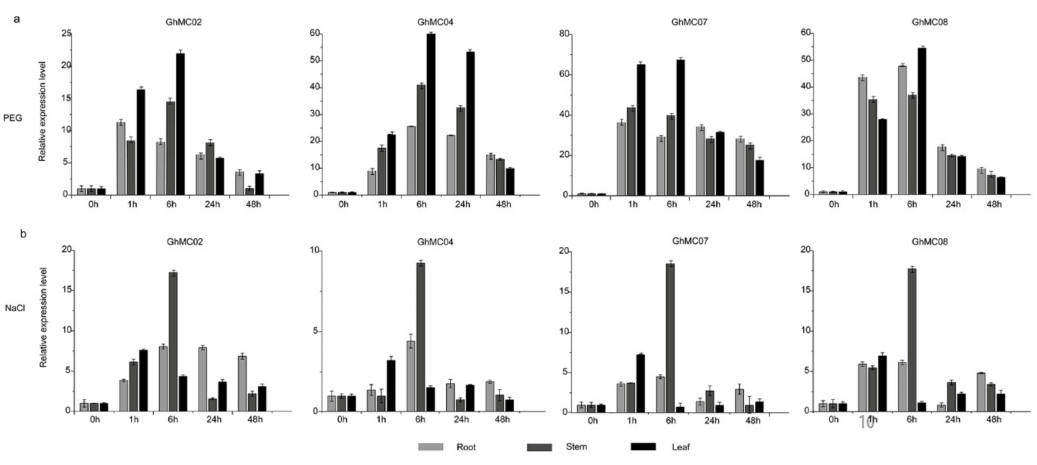
Figure 6. Analysis of GhMC expression levels following abiotic stress treatments according to a qRT- PCR assay. ( a ) 20% PEG 6000 treatment; ( b ) 200 µ M NaCl